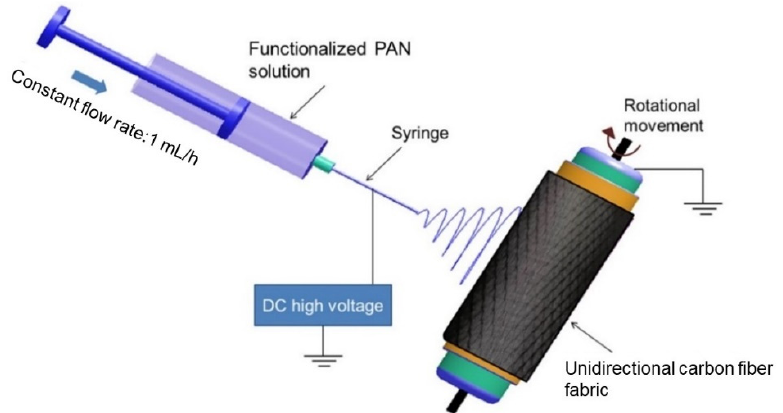
Figure 1. Electrospinning setup for depositing nanofibers on the surfaces of carbon fiber.